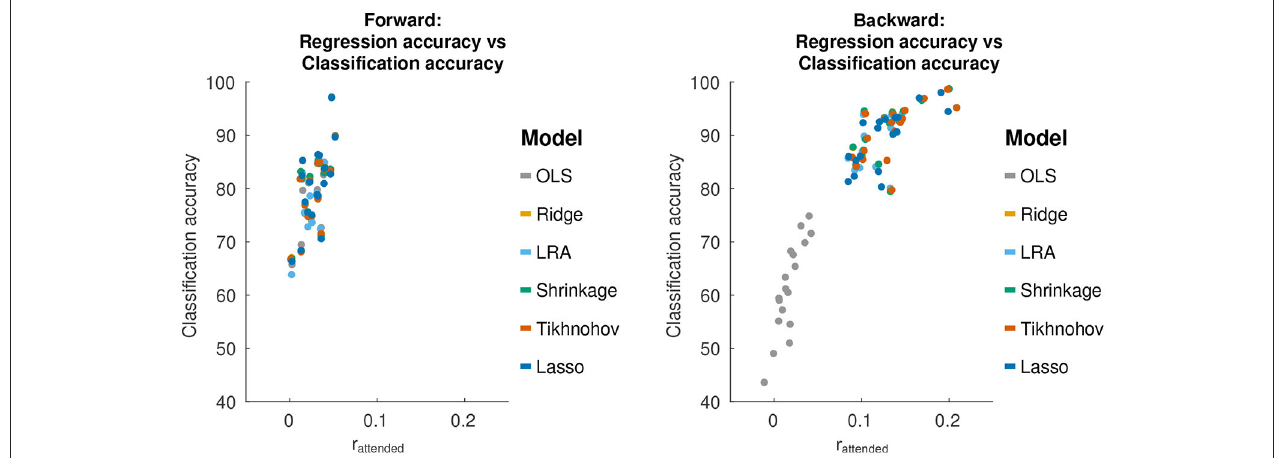
FIGURE 4 | Relationship between regression accuracy and classification accuracy, using 30 s decoding segment